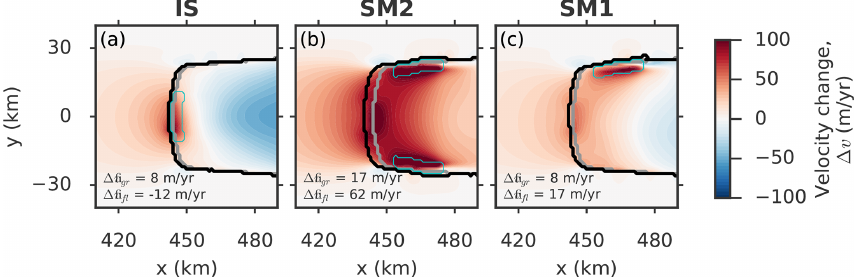
Figure 6. Change in ice speed (cid:49)v (colorbar) in the vicinity of the grounding line at the end of the 100 year perturbation for the three different perturbation types and an applied melt-strip width of w = 4km. In each panel the spatial mean of the grounded and floating speed changes (average over the displayed area), (cid:49) ¯ v gr and (cid:49) ¯ v fl , respectively, are given in the lower left corner. Thick contours represent the grounding-line position in the initial state (gray) and in the perturbed states (black). The thin cyan contour denotes the perturbation area. Note that the total melt rate P is 2Gtyr − 1 in the IS and SM2 cases and 1Gtyr − 1 in the SM1 case for a better comparability between the SM1 and SM2 cases. The pattern of changing ice-speed is shown for further time slices in Fig.